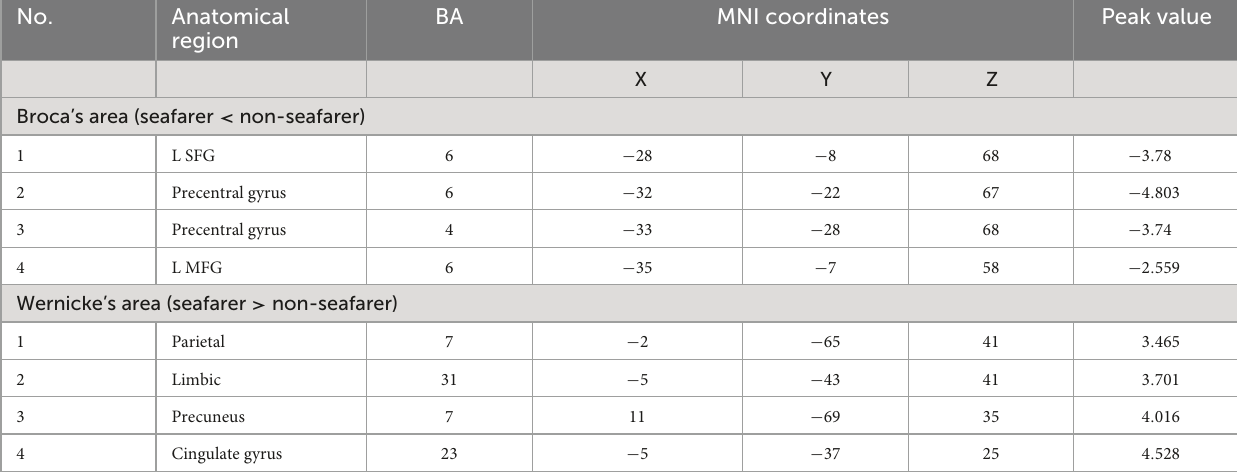
TABLE 1 The cerebral cortex involved significant functional connectivity with Broca’s and Wernicke’s areas in the seafarer group and the non-seafarer group ( p 0.005, cluster size > 200 voxels, corresponding to corrected p FWE